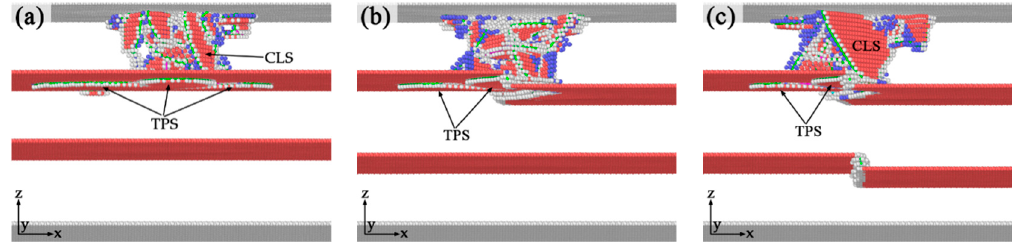
Figure 9. Atomic configurations of dislocation structures of three different models at indenter depths d = 9 Å. ( a ) TPT; ( b ) SDT; ( c ) TDT.